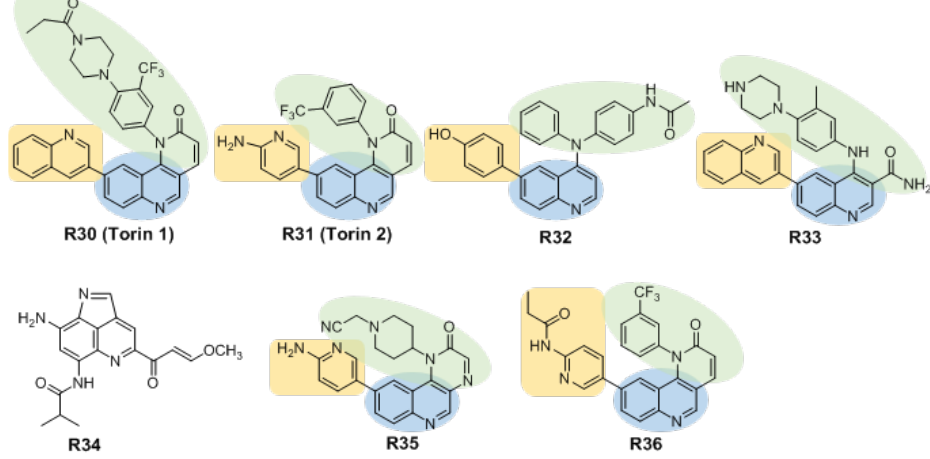
Figure 5. Structures of inhibitors based on quinoline. They are described as scaffold involving three regions: the hinge region (blue), the hydrophobic region (buff) and variable region (green). R34 is not described.